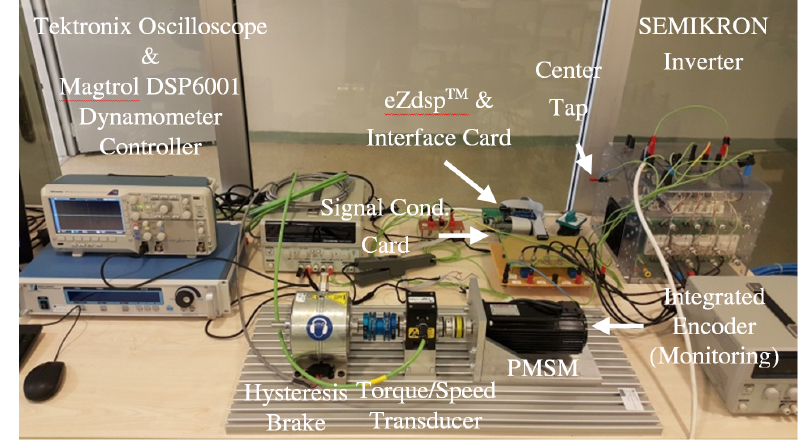
Figure 6. Experimental